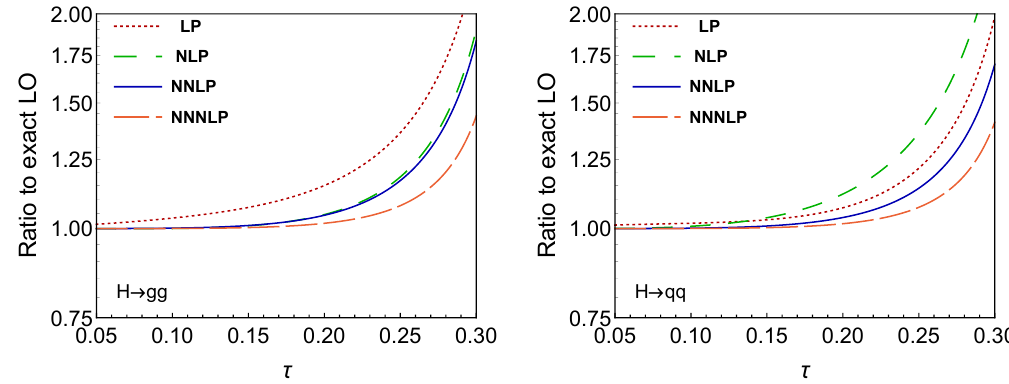
Figure 10 . The ratios of the LP, NLP, next-to-next-to-leading power (NNLP), and next-to-next- to-next-to-leading power (NNNLP) results to the exact